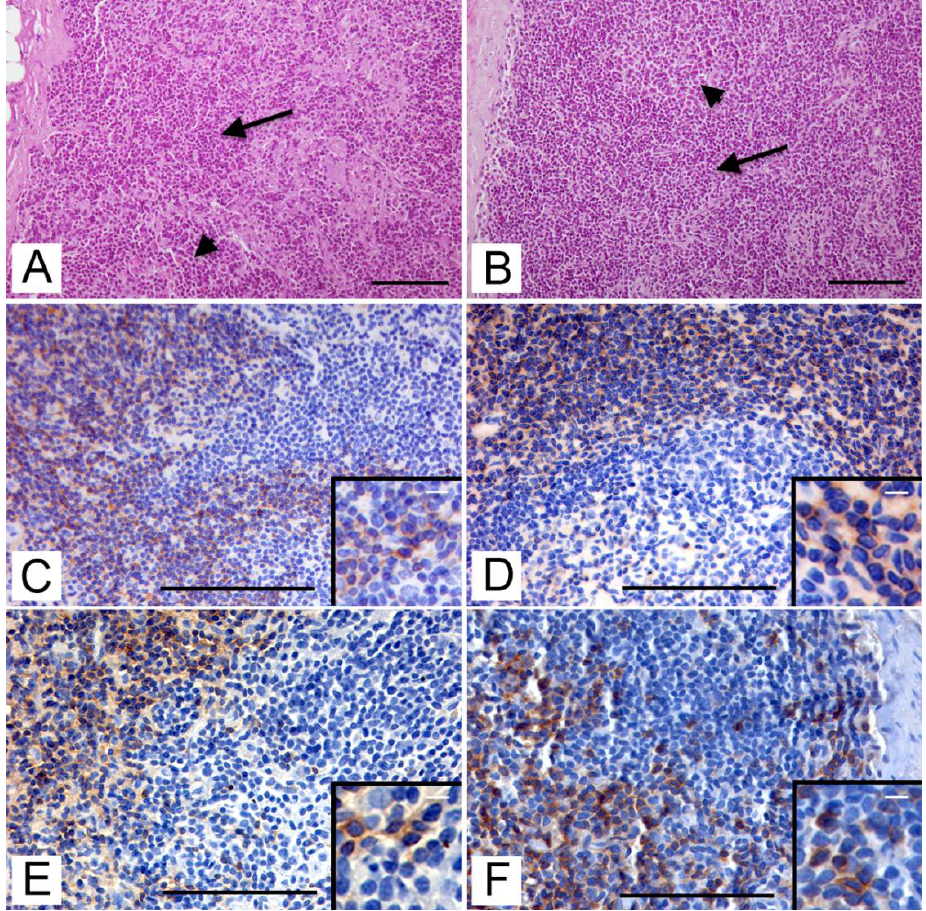
Figure 2. Immunolocalization of T-cells on lymph node tissue by immunohistochemistry (IHC). ( A ) Roe deer. Interfollicular area (arrow) and lymphatic follicle (arrowhead) in lymph node cortex (H-E, bar = 100 µ m). ( B ) Fallow deer. Interfollicular area (arrow) and lymphatic follicle (arrowhead) in lymph node cortex (H-E, bar =100 µ m). ( C ) Roe deer. Immunohistochemical staining with anti-CD3 (Santa Cruz) antibody in the interfollicular area of the cortex (IHC, bar = 100 µ m). Inset: CD3-positive T lymphocytes in the interfollicular area (IHC; bar = 15 μm). ( D ) Fallow deer. Immunohistochemical staining with anti-CD3 (Dako) antibody bordering a lymphatic follicle (IHC, bar = 100 m). Inset: CD3- positive T lymphocytes in the interfollicular area (IHC; bar = 10 μm). ( E )